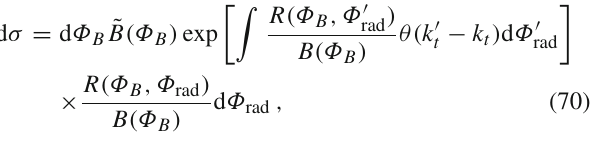
¯ b ( b ) jets as the jets containing the hardest b (